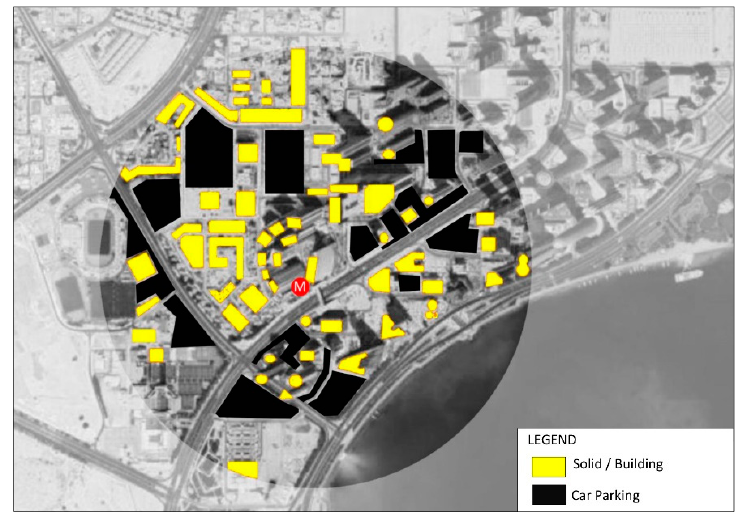
Figure 26. Illustration of solid (i.e., buildings, colored yellow) and void (car parking, colored black) areas. The red circle with the “M” shows the location of the West Bay metro station (Source: the Authors).